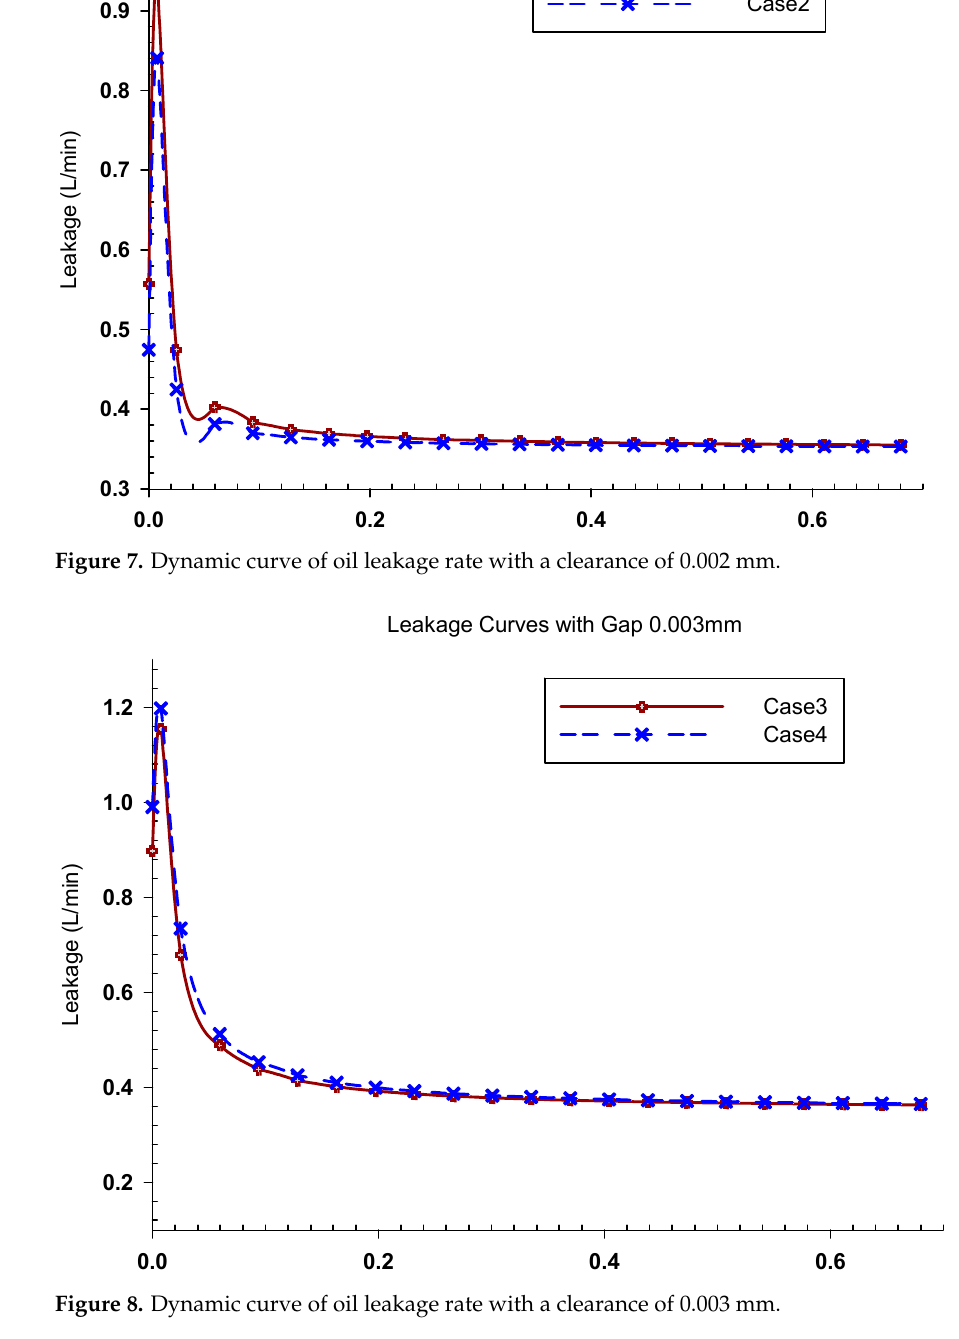
Figure 9. Statistical distribution chart of zero oil leakage rate.